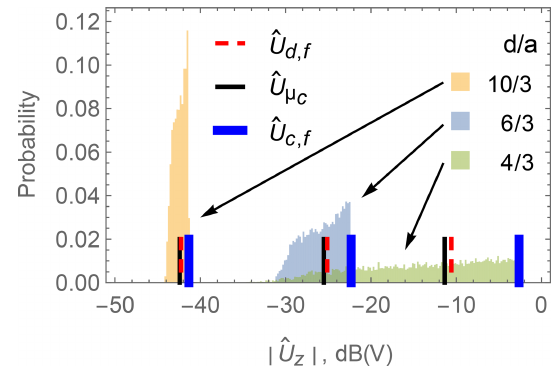
Figure 5. Simulated distributions of the induced voltage | ˆ U z | in a pick-up coil for a circularly modeled 3-D coil with radius a in ran- dom orientations at three selected distances d between the 3-D coil and the pick-up coil in an inhomogeneous primary field generated by the exciter